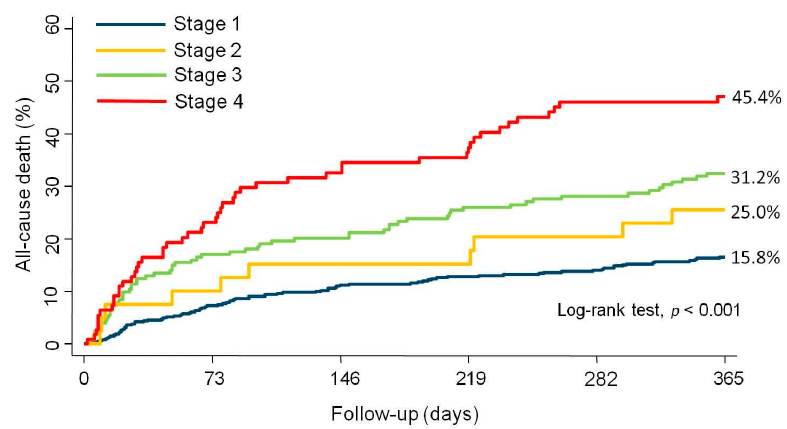
Figure 3. Kaplan–Meier estimates for the cumulative event rates of all-cause mortality according to the stage of right ventricular dysfunction.